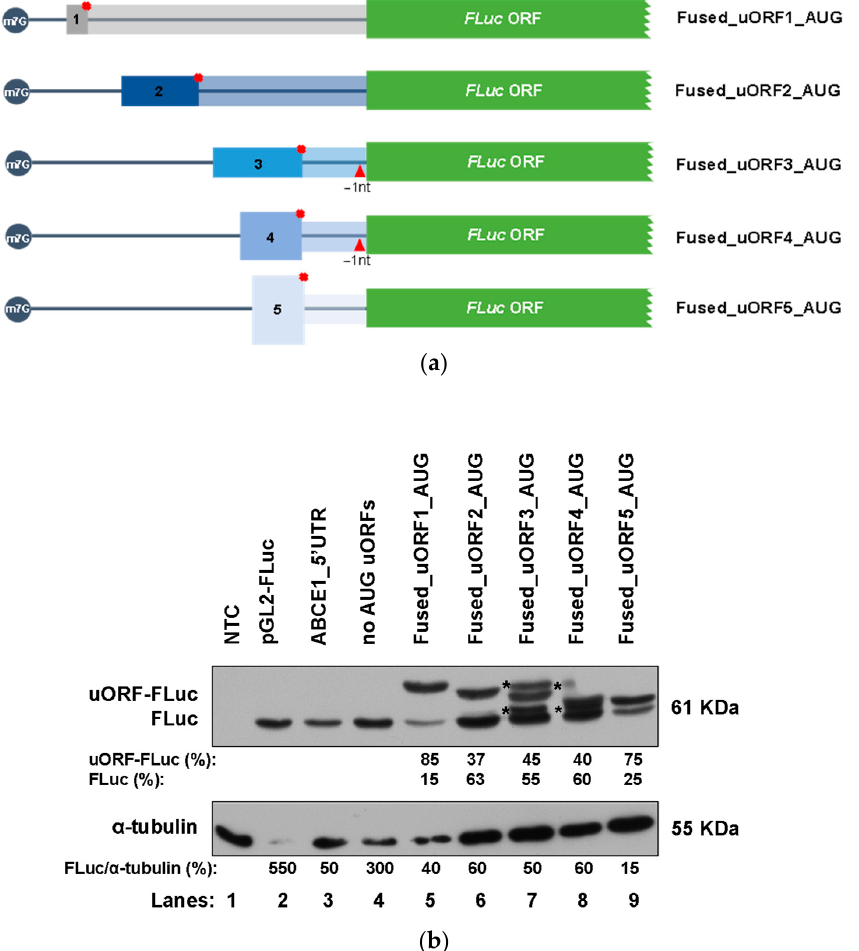
Figure 5. The five ABCE1 AUG uORFs have the potential to be translated, being uORF1 and uORF5 the most efficiently recognized by the ribosomes. ( a ) Schematic representation of the constructs, in which the AUG uORF was fused in frame with the FLuc coding sequence. In the constructs uORF3 and uORF4, 1 nucleotide (T) was deleted from the intercistronic sequence, and, in uORF1-5, the in-frame stop codon was mutated (TGA → GGA), resulting in the following constructs: Fused_uORF1_AUG, Fused_uORF2_AUG, Fused_uORF3_AUG, Fused_uORF4_AUG, and Fused_uORF5_AUG. The red cross represents the point mutation at the uORF’s stop codons, and the red triangle indicates the 1-nucleotide deletion. The five non-AUG uORFs are present in these constructs but not represented in the figure to simplify the scheme. ( b ) HCT116 cells were transiently transfected with each one of the constructs depicted in ( a ) or, ABCE1_5 ′ UTR, “no AUG uORFs” (both described in Figure 2a), or the pGL2-FLuc empty vector (to monitor native FLuc expression). Native FLuc protein and N-extended uORF-FLuc isoforms were assessed by Western blot using a specific antibody against FLuc. Alpha-tubulin was used as a loading control. This is a representative immunoblot from at least three independent experiments. The asterisks (*) represent translation initiation at other initiators; NTC: non-transfected control.